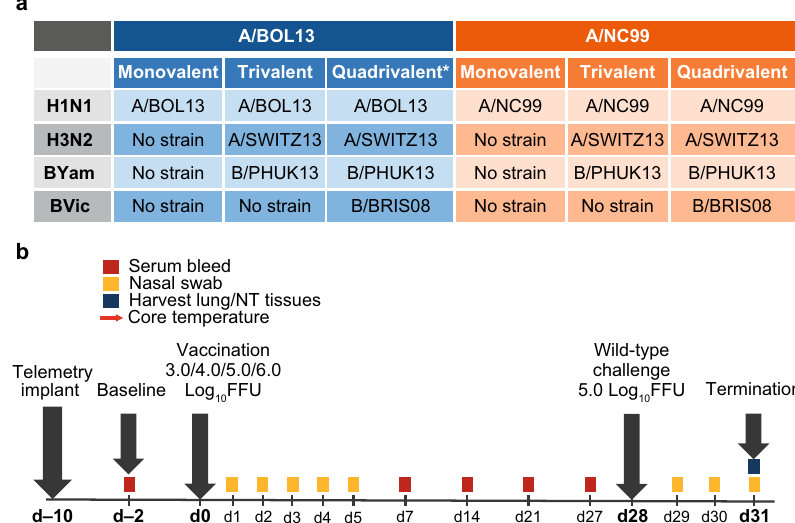
Fig. 1 Study schedule for comparison of H1N1 LAIV of varying fi tness in ferret model. a Composition of vaccine formulations. Rows detail subtype composition. n/a indicates no strain was present for that subtype. b Ferrets were intranasally vaccinated at Study Day 0 with monovalent, trivalent, or quadrivalent LAIV formulations over a range of doses. Gray arrows indicate major interventions over the 31-day study course. Colored boxes highlight sampling points, with time in days on horizontal axis. Red arrow indicates hourly telemetry recording of core body temperature. *Representative of 2015 – 16 commercial formulation. d day, A/BOL13 A/Bolivia/559/2013, A/NC99 A/New Caledonia/ 20/1999, A/SWITZ13 A/Switzerland/9715293/2013, B/BRIS08 B/Brisbane/60/2008, B/PHUK13 B/Phuket/3073/2013, FFU fl uorescent focus units, LAIV live attenuated in fl uenza vaccine, NT nasal